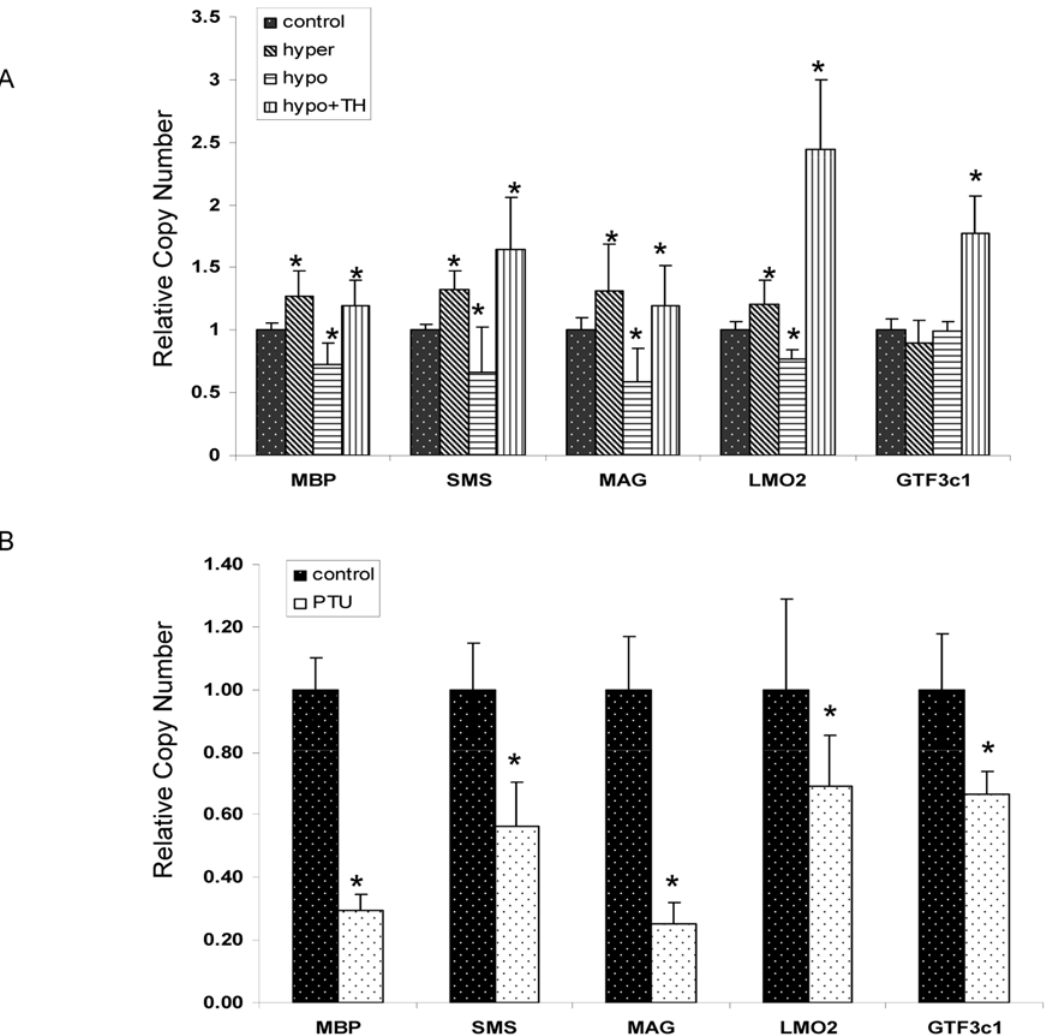
Figure 5. The expression of novel thyroid responsive genes in hypothyroid or hyperthyroid mouse models. A. MMI/perchlorate induced hypothyroid, hyperthyroid or hypothyroid/replacement animal models. B. PTU induced hypothyroid animal models. RT-PCR was performed with RNA extracted from cerebellum on PND15 (n=5). * Significantly different from control ( p , 0.05).